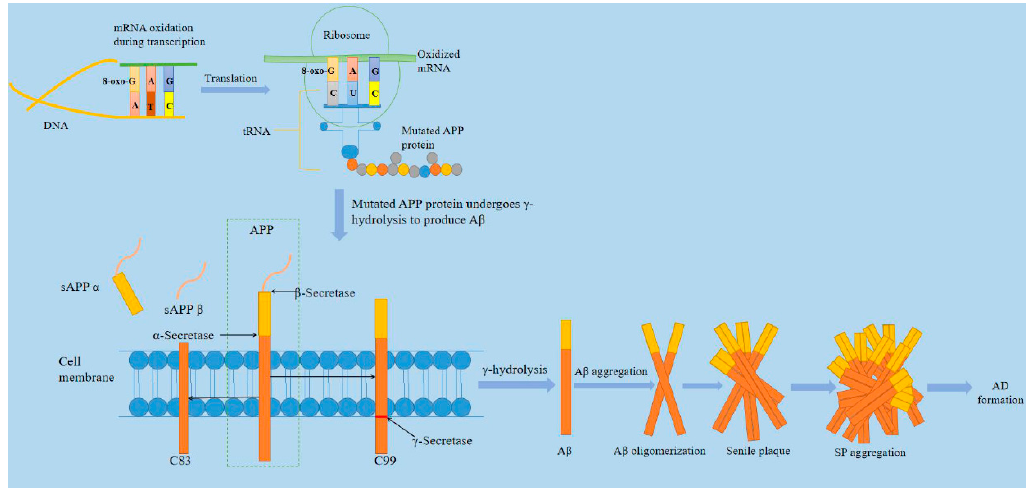
Figure 2. A brief mechanism of Alzheimer's disease. The mRNA of amyloid precursor protein (APP) gene changes the process of gene transcription and translation due to the base mismatch produced by oxidation, which leads to the change of amino acid sequence of APP protein. Mutant APP protein produces more types and quantities of β -amyloid protein (A β ) fragments through pathological β and γ hydrolysis pathways, and aggregates to form senile plaque (SP), to initiate the pathological process of AD [75].